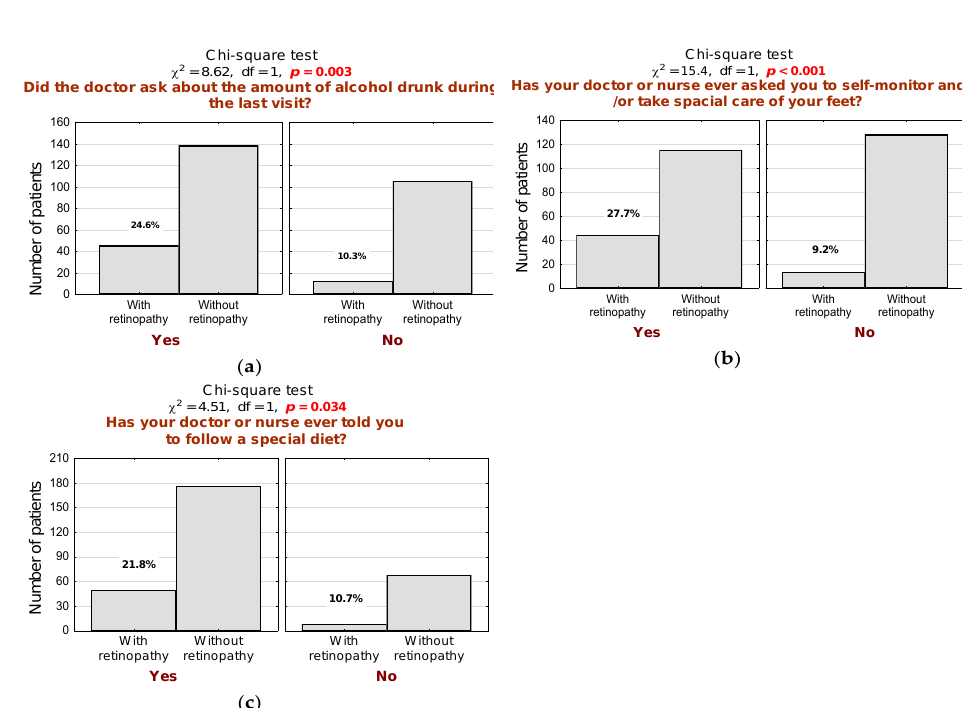
( d ) number ( n ) and percentage (%) of patients in groups differing in the presence of diabetic retinopathy and densitometry testing and the result of the independence test .